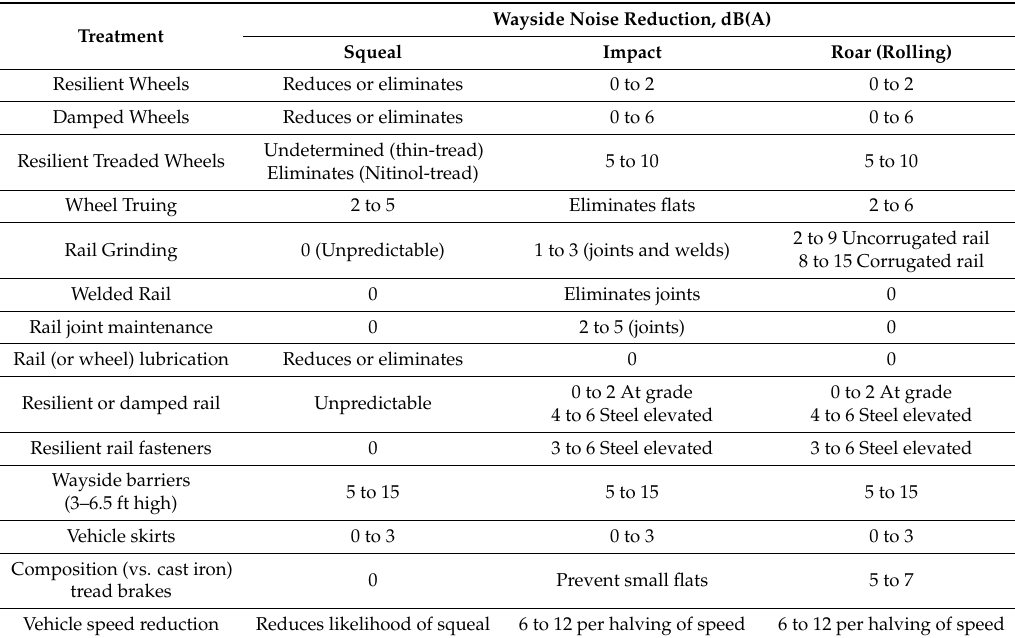
Table 2. Noise mitigation measures reduction values [2].